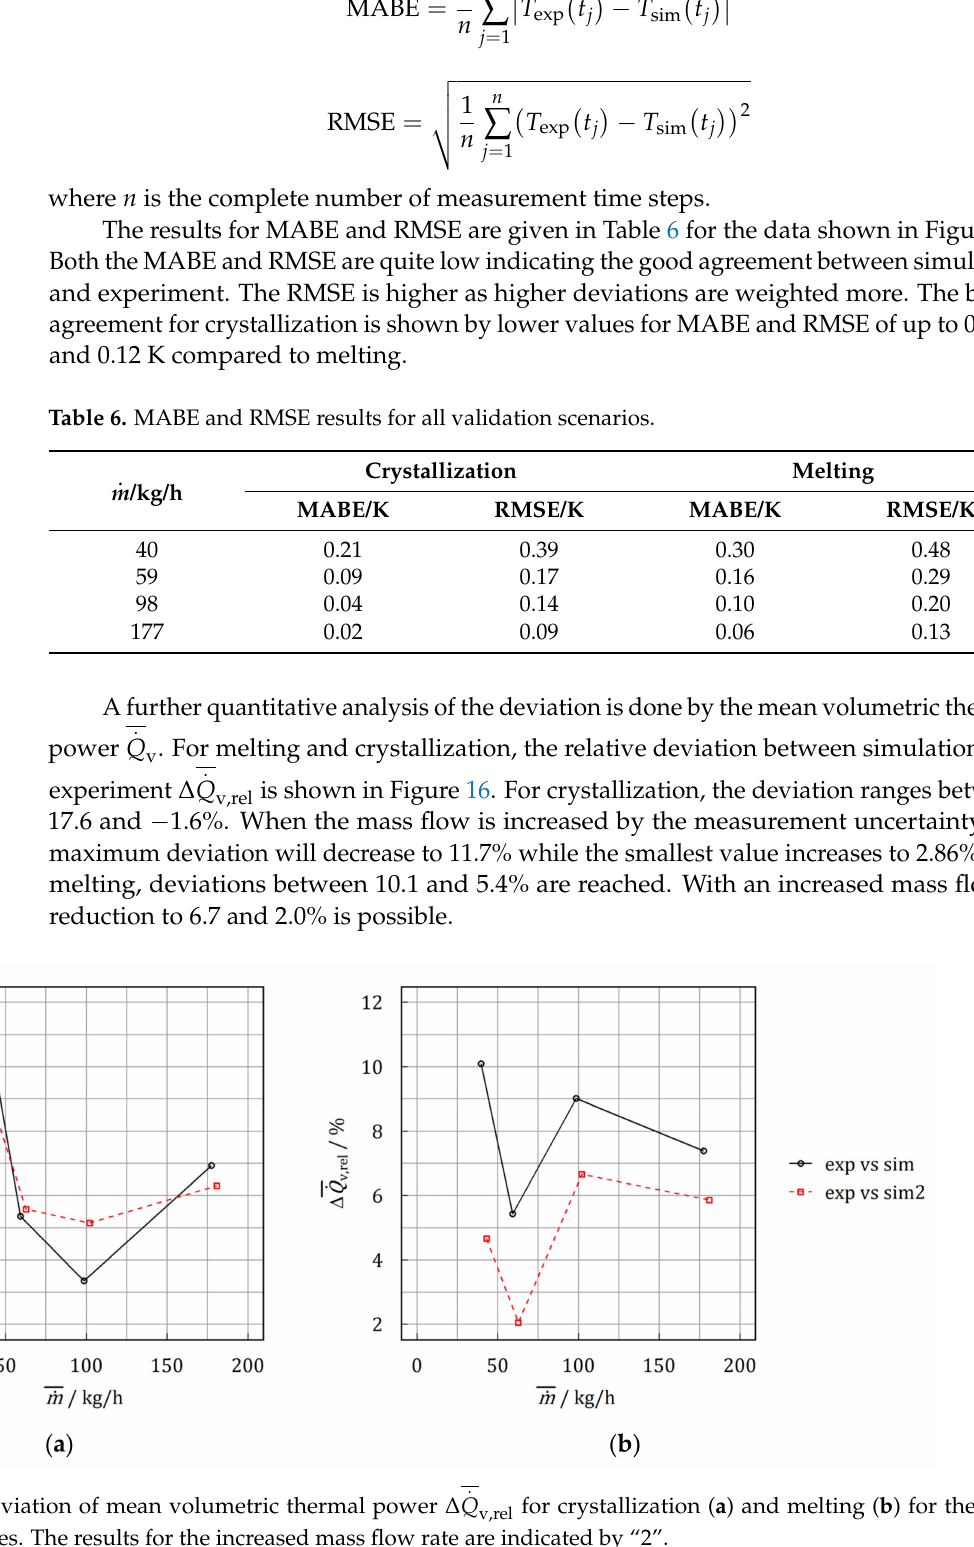
Figure 16. Relative deviation of mean volumetric thermal power ∆ different mass flow rates. The results for the increased mass flow rate are indicated by